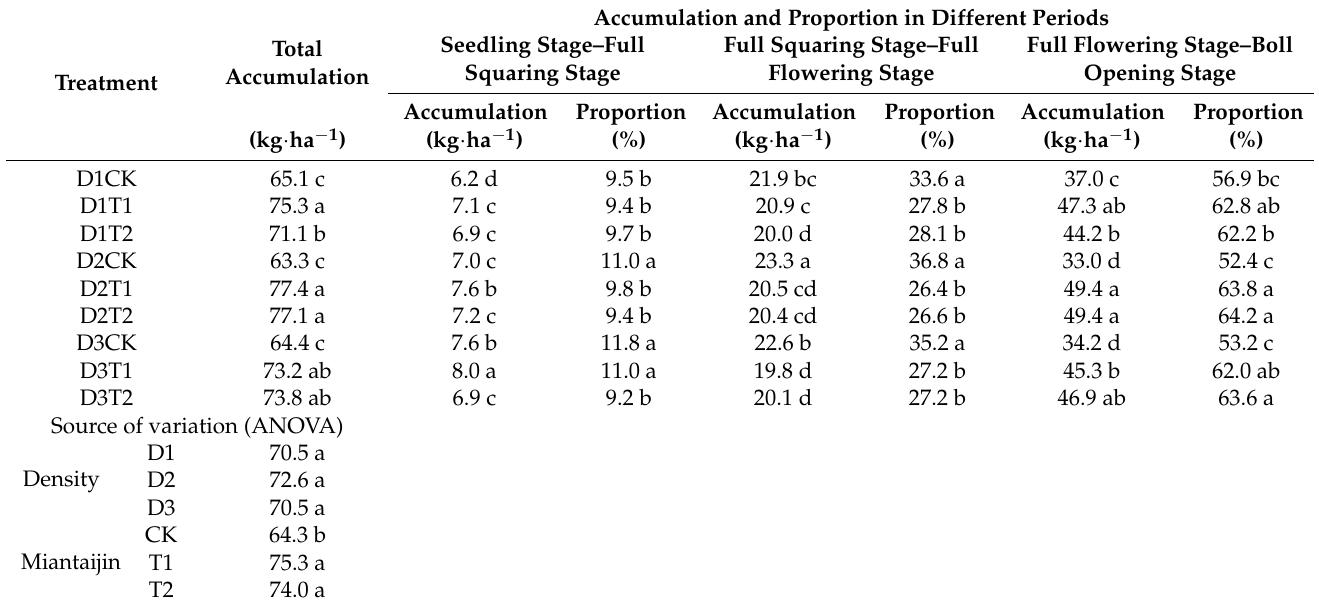
Table 4. Effects of density and Miantaijin on P accumulation